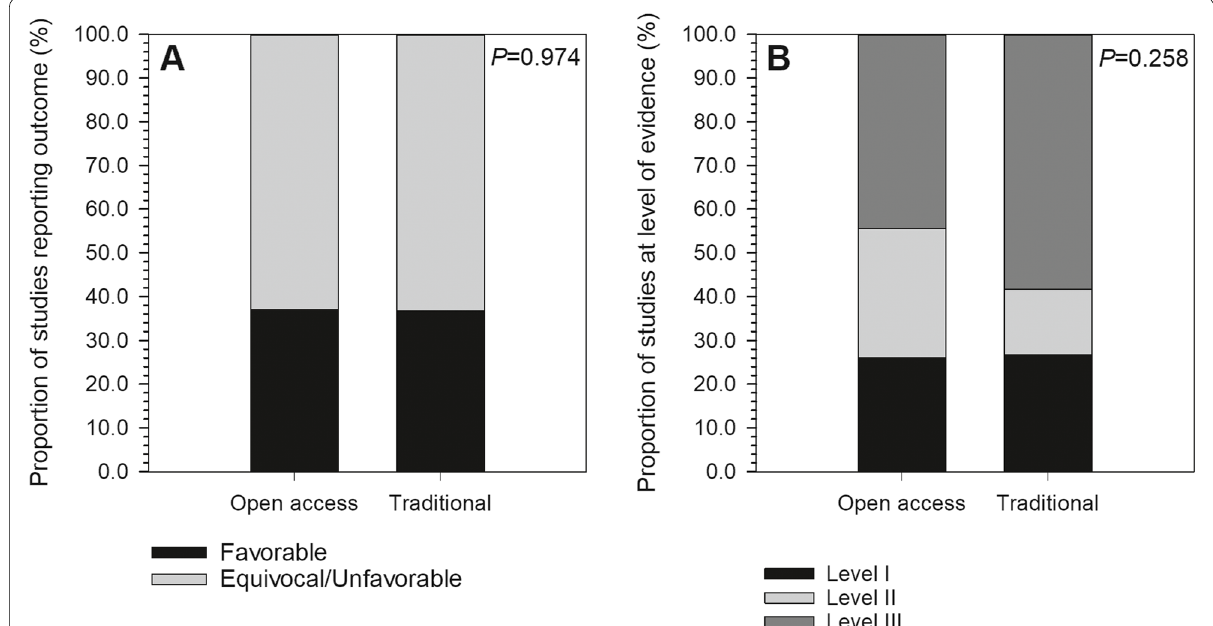
Fig. 5 A Proportions of studies reporting favorable outcomes (black bar segments) or equivocal/unfavorable outcomes (gray bar segments), with comparison between studies published in open access vs . traditional journals. Outcome proportions were not significantly different between journal types. B Proportions of studies reporting Level I evidence (black bar segments), Level II evidence (light gray bar segments) or Level III evidence (dark gray bar segments), with comparison between studies published in open access vs. traditional journals. Level of evidence distributions were not significantly different between journal types